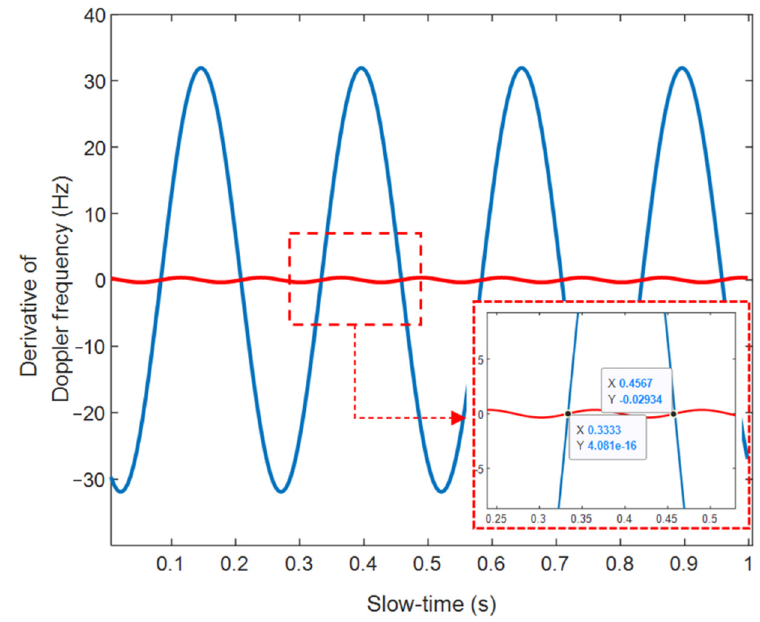
Figure 11. Make f d (cid:48) ( t m ) = 0, the slow-time (within a period) corresponding to the maxi- f t ( ) 0 , the slow-time (within a period) corresponding to the maximum ure 11. Make ' = d m mum value are t max = 0.3333 sor0.457 s, and A ( t max ) = 7.9756. According to Equation (23), t 0.3333 s or 0.457 s , and = A t ( ) 7.9756 . According to Equation (23), value are = max max ˆ r 1 = 0.3178 m and ˆ r 2 = 0.5731 m. ˆ r = 0.3178 m and ˆ r = 0.5731 m . 1 2